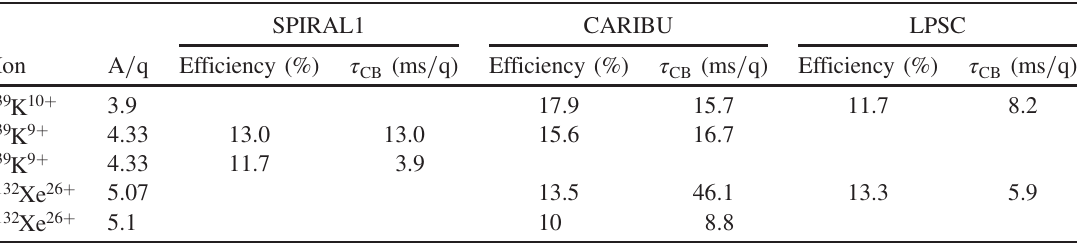
TABLE I. Examples of efficiencies and τ achieved efficiencies or the best compromise between τ charge breeders.